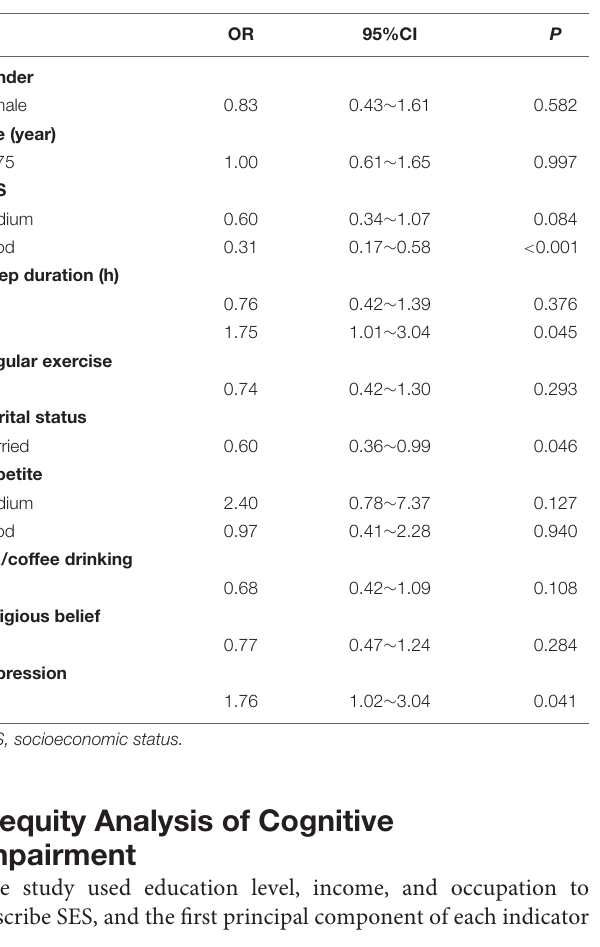
TABLE 2 | Regression analysis results for cognitive impairment. TABLE 3 | First principal component weights of variables related to SES.